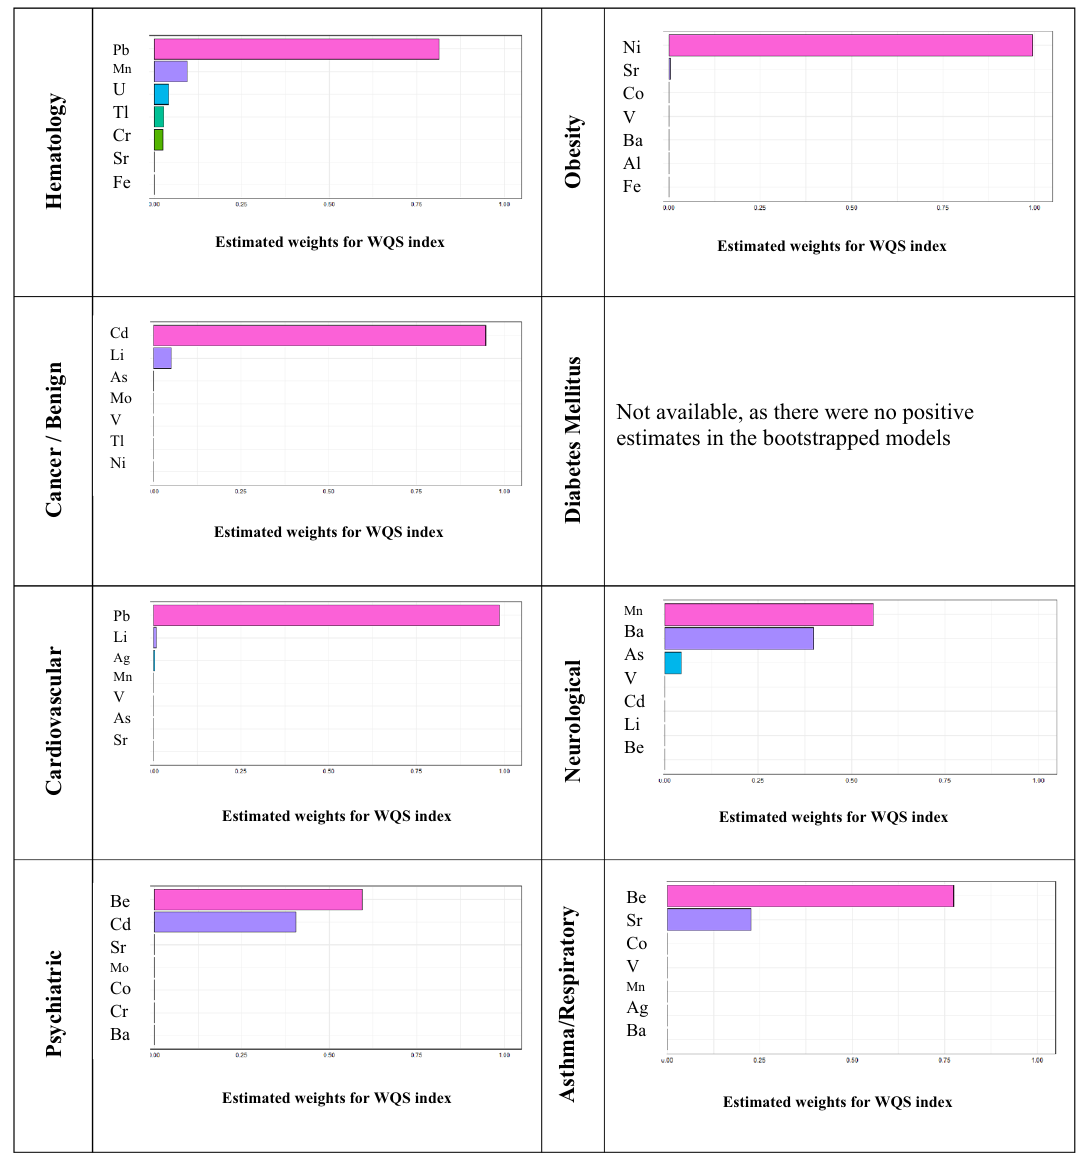
Figure 1. Metals’ burden on morbidity. Results of Weighted Quantile Sum Regression